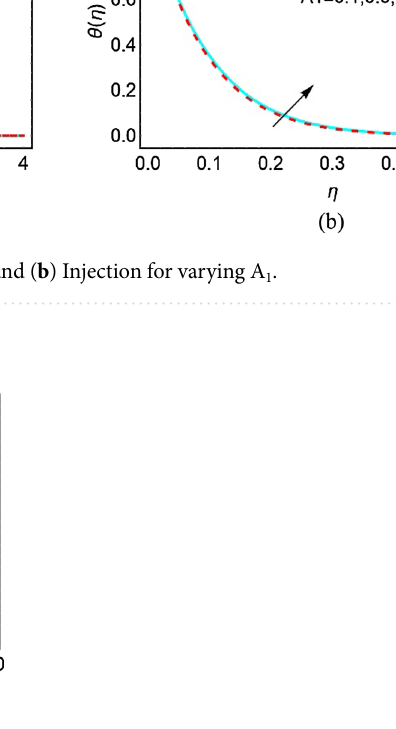
Figure 7. The Temperature against f w